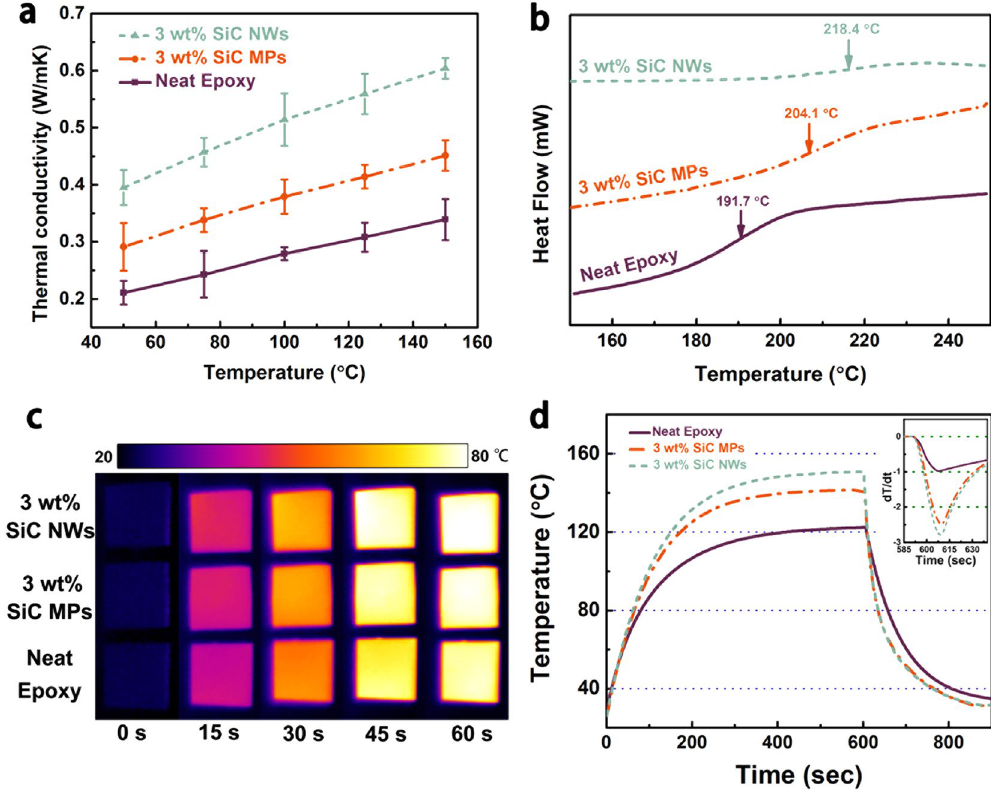
Figure 6. ( a ) Thermal conductivity of neat epoxy and epoxy composites as a function of test temperature; neat epoxy and epoxy composites: ( b ) DSC curves, ( c ) infrared images, ( d ) Surface temperature variation with time upon heating and cooling